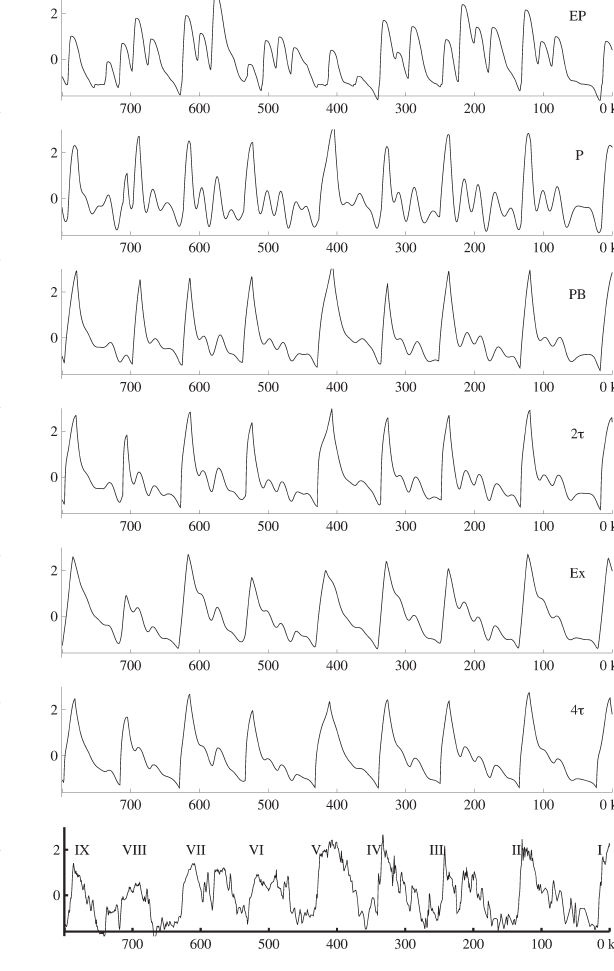
f ig . 2. – Best fits obtained for the CO observed time series, when 2 (top to bottom) the following models are used: (a) Paillard model without deep stratification mechanism and with a model for bio- f ig . 1. – Best fits obtained for the d 18 O observed time series, when logical exportation; (b) original Paillard model; (c) original Paillard (top to bottom) the following models are used: (a) Paillard model model without astronomical forcing on CO ; (d) Different response 2 without deep stratification mechanism and with a model for bio- times for emission and absorption of CO ; (e) previous model with 2 logical exportation; (b) original Paillard model; (c) original Paillard oceanic pulse of CO exponentially dependent on the stratification; 2 model without astronomical forcing on CO ; (d) Different response and (f) model with different response times for emission and absorp- 2 times for emission and absorption of CO ; (e) previous model with tion of CO as well as for accumulation and ablation of ice. The 2 2 oceanic pulse of CO exponentially dependent on the stratification; simulations are compared with the experimental time series (bottom 2 and (f) model with different response times for emission and absorp- figure) available for CO (Lüthi et al . 2008). Roman numbers corre- 2 tion of CO as well as for accumulation and ablation of ice. The sponding to the nine glacial terminations have been 2 simulations are compared with the experimental time series (bottom panel) available for ice volume (Lisiecki, 2005).